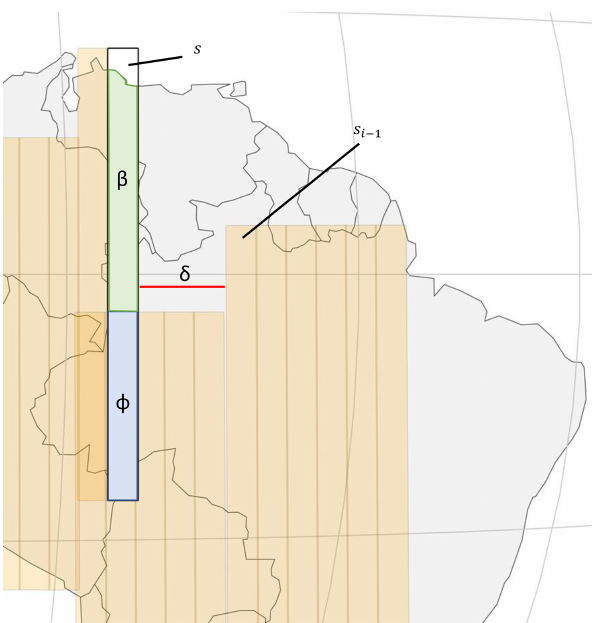
Figure 2. A diagram explaining the objective function, c(s,t) , used in the IO routine. The block labeled s i − 1 is the last selected block and the block labeled s is the block for which c(s,t) is being calcu-